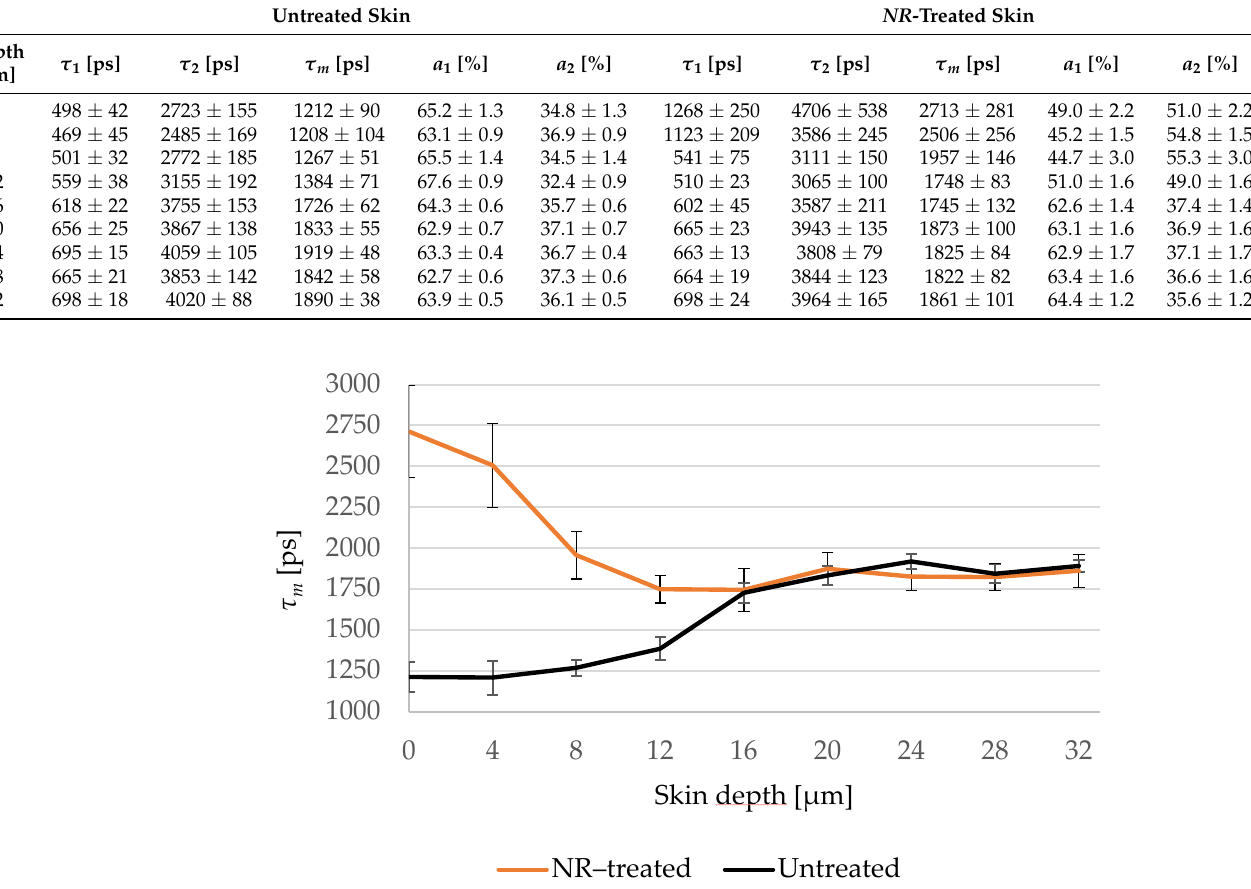
Figure 8. Changes of τ m of the NR -treated (orange line) compared to the untreated (black line) skin depending on the depth at 4 μ m increments. τ m of the NR -treated skin decreases in the deep SC and overlaps with the untreated skin in the viable epidermis. SC thickness is 16.0 ± 3.3 μ m. N = 6.